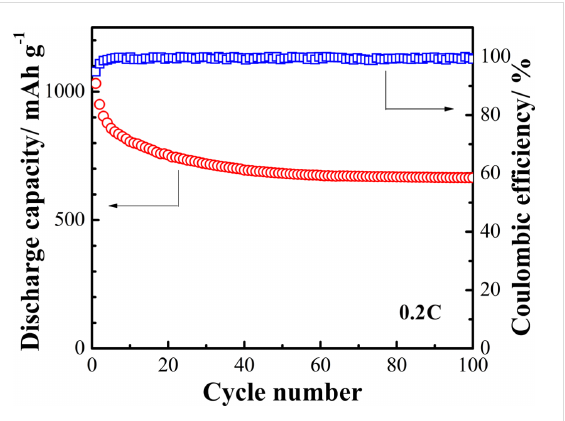
Figure 6: Discharge/charge voltage profiles of the S/ZnO@NCNT cathode for the initial three cycles at 0.2C. Figure 7: Cycling performance of the S/ZnO@NCNT cathode at